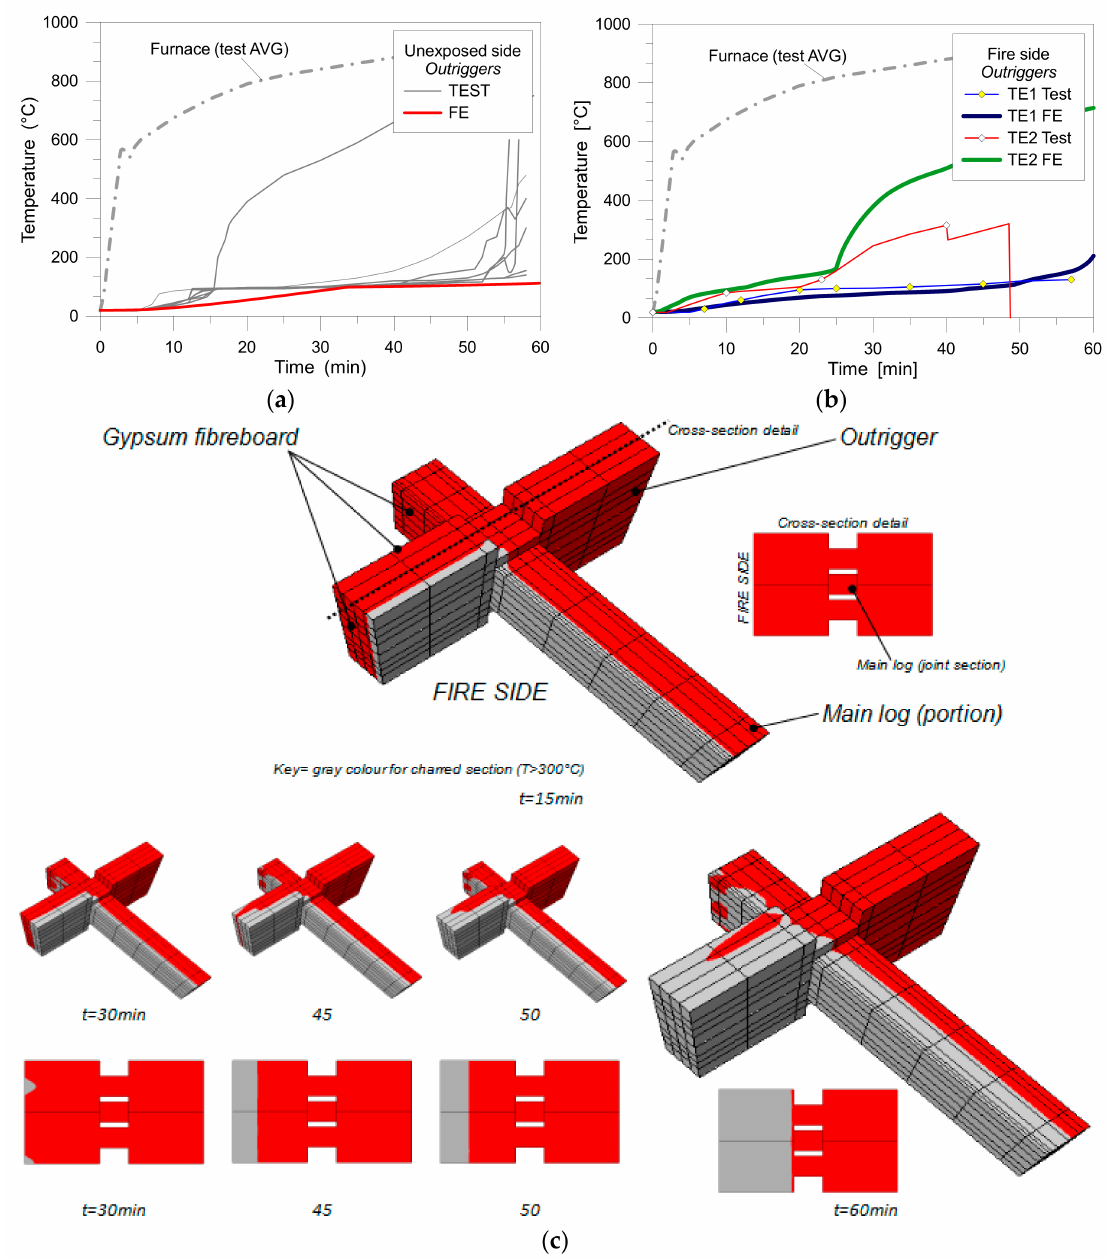
Figure 10. FE heat transfer results (ABAQUS). ( a ) Experimental and numerical evolution of temperature in the region of carpentry joints, with ( b ) temperature variation within the gypsum fibreboard layers and ( c ) residual section evolution in selected logs (charred section in gray), after t = 15-to-60 min of fire